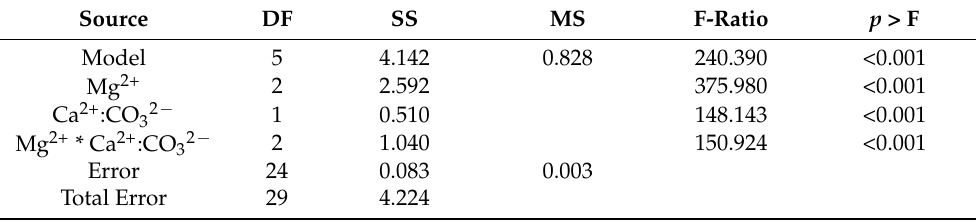
Table 2. Two-way factorial ANOVA and least square (LS) means difference. The effect test showed significant interaction between Ca:CO 3 and Mg concentration. Tukey–Kramer HSD comparisons indicates a significant difference between Mg-free and high Ca:CO 3 , and all other treatments, as well as Mg-free and low Ca:CO 3 and all other